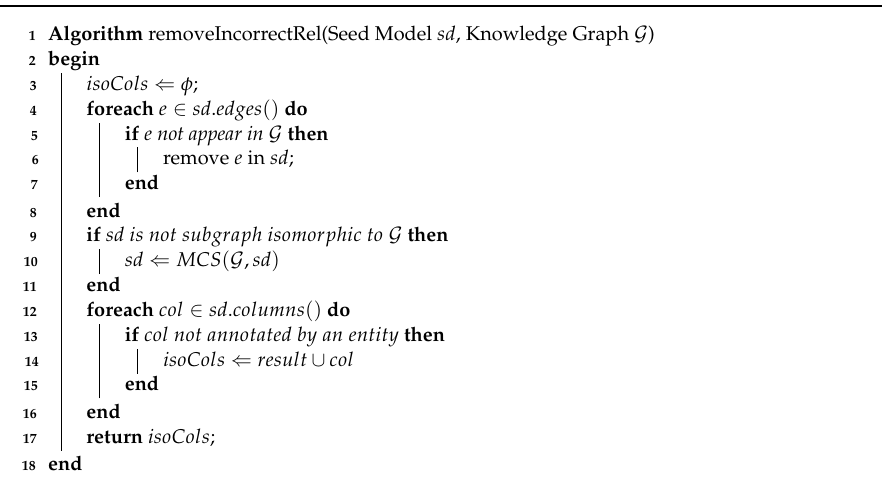
Figure 5. The change of seed model of CB after removing incorrect relationships. Algorithm 1: Algorithm for removing incorrect